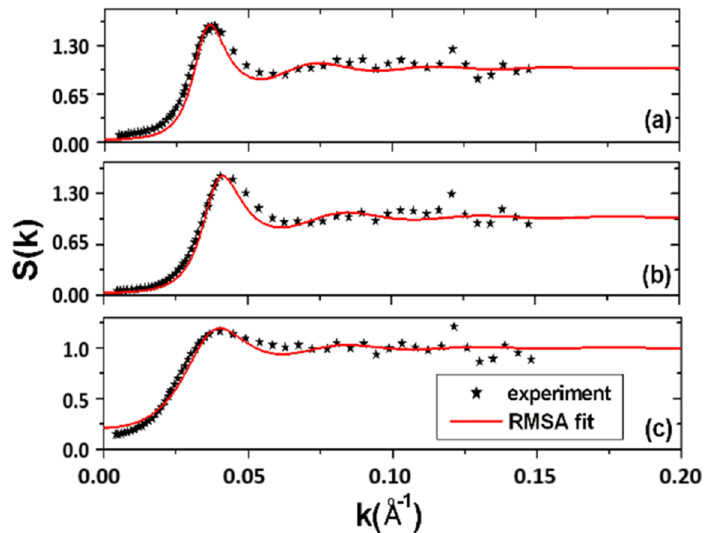
Figure 6. The liquid theory of RMSA fits the experimental S ( k ) taken from Meriguet, G. et al. [2] at three ferrofluid volume fractions ϕ ; 0.109 ( a ), 0.17 ( b ), 0.219 ( c ). Calculations of the colloid diffusion constant with Equation (1) and viscosity, Equation (2), are reported in Table 2. Adapted with permission from Ref. [2]. Copyright 2022 IOP Publishing, Ltd.